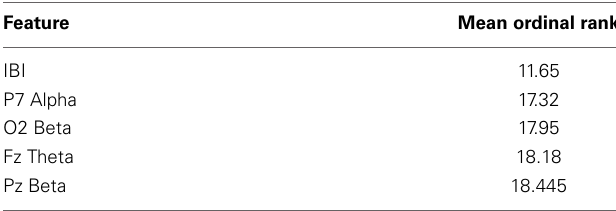
Table 4 | Mean ordinal rank of features (top 5 of